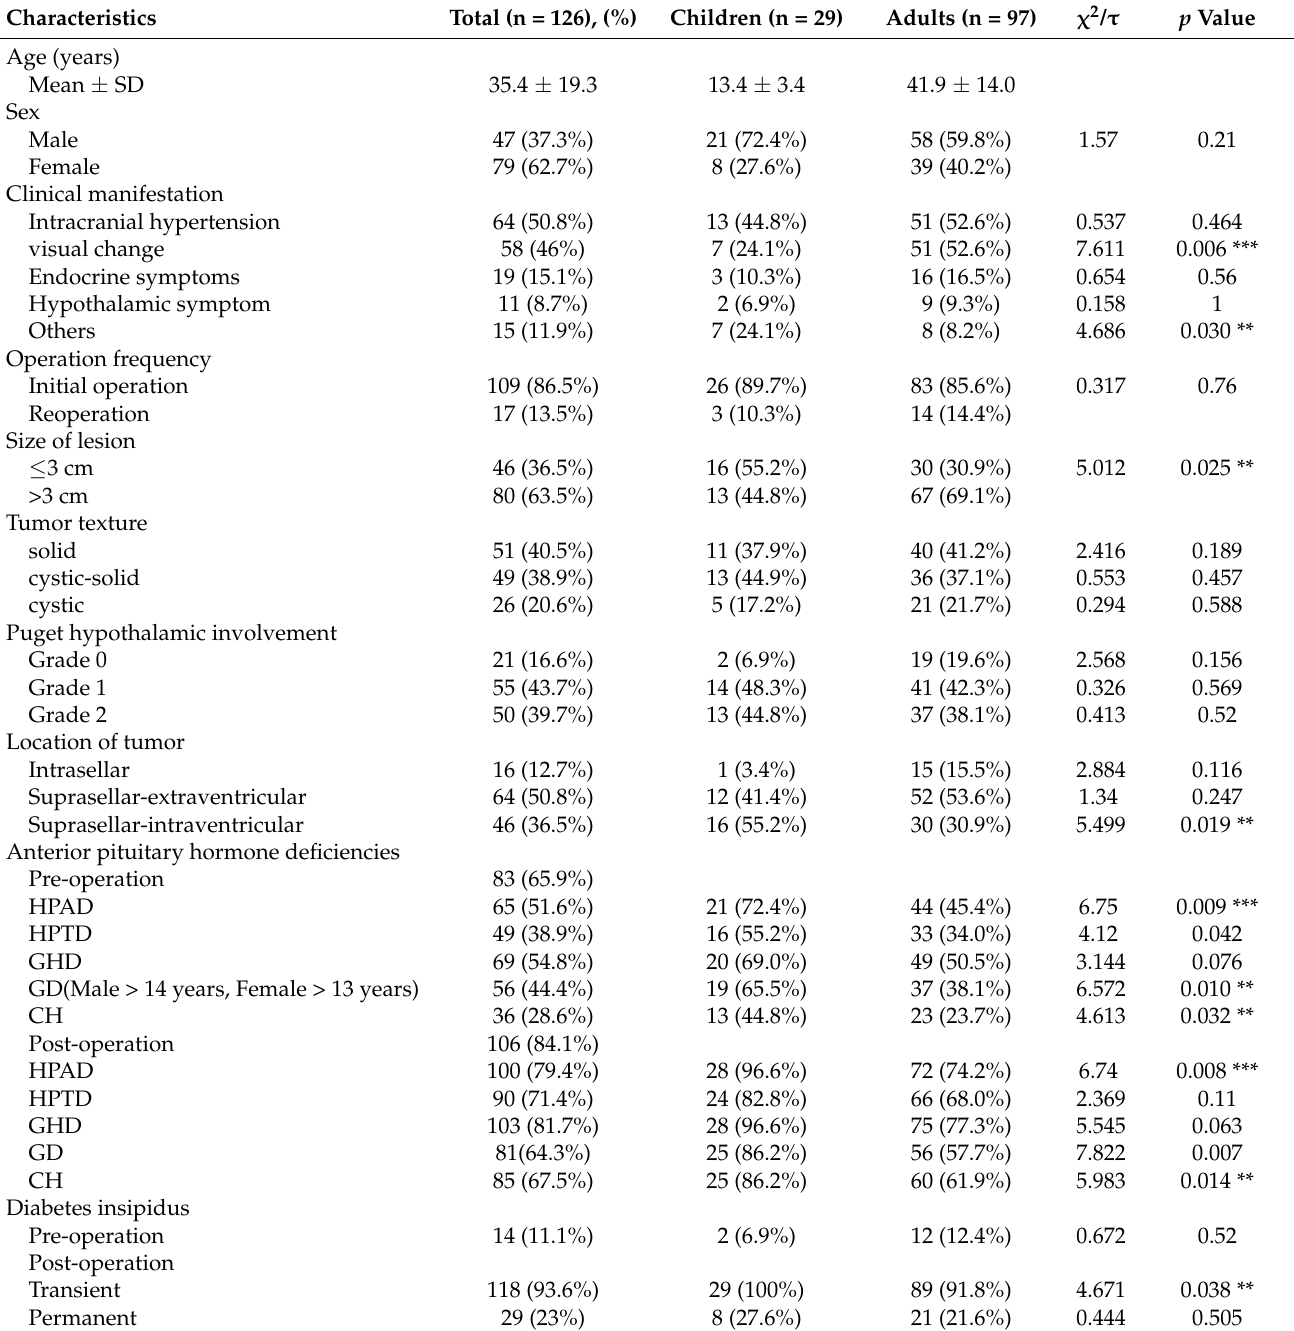
Table 1. Demographics and clinical characteristics of the